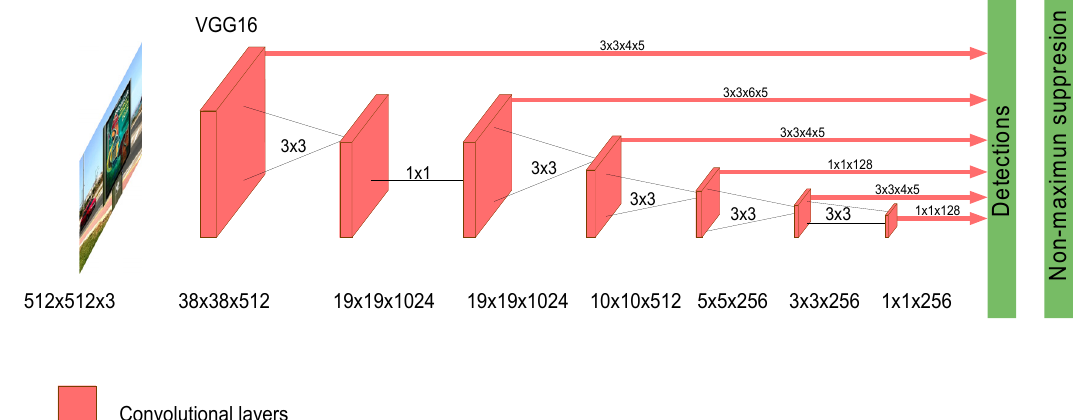
Figure 2. Layer architecture of Single Shot Multibox Detector (SSD) network.